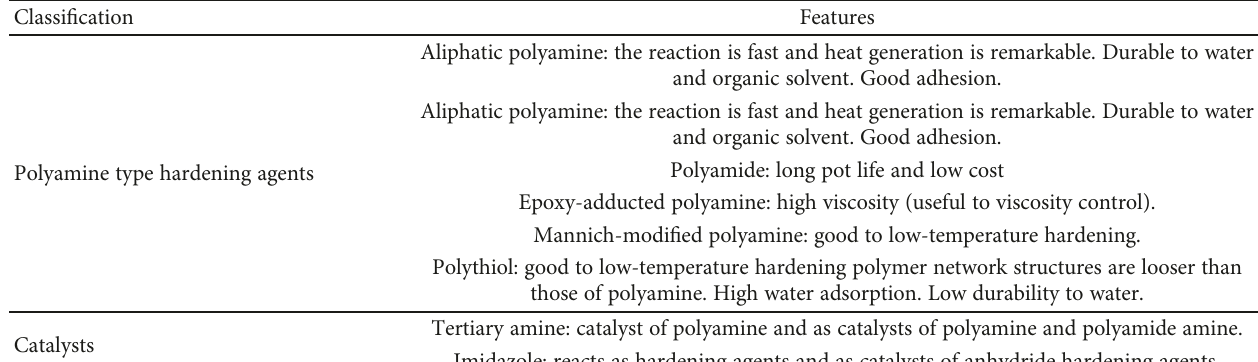
Table 3: Classi fi cation of hardening agents used for epoxy resin adhesives.